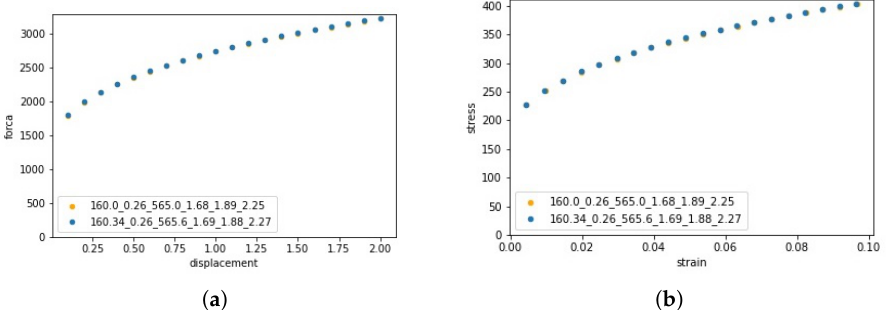
Figure 12. ( a ) Force-displacement and ( b ) stress-strain curves obtained with the predicted parameters for the cruciform test case